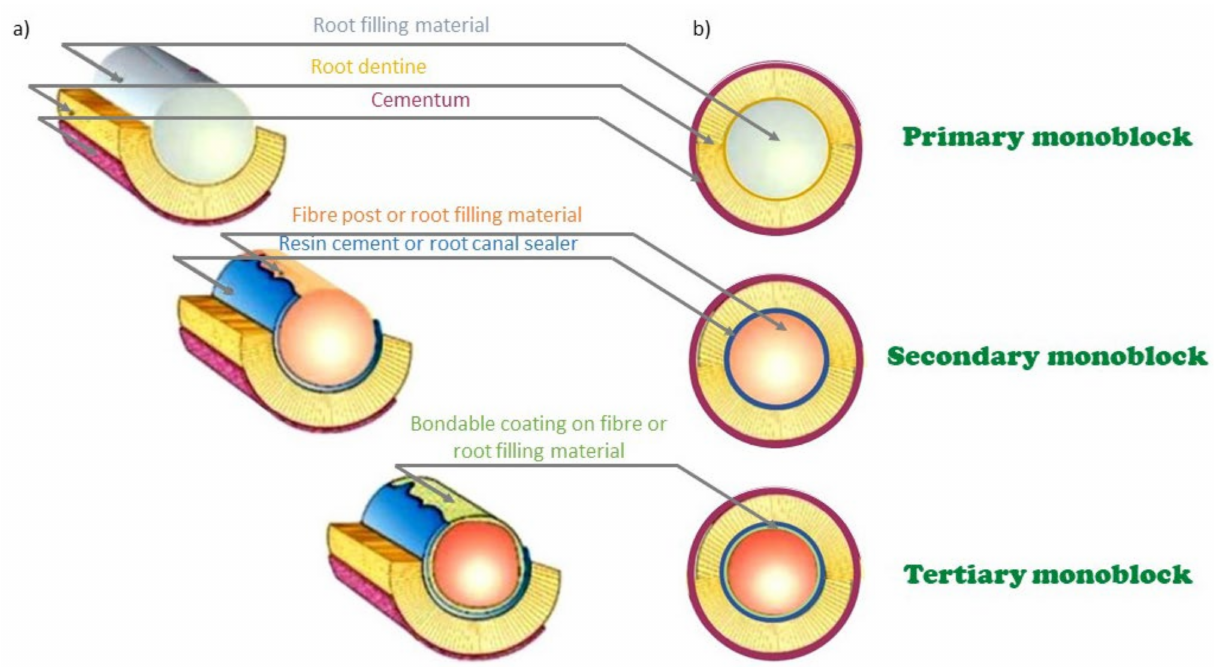
Figure 10. Structure diagram of monoblocks in endodontics: ( a ) half-section of a tooth fragment filled with filling material with or without intermediate layers in the axonometric view; ( b ) cross-section of the obturated tooth